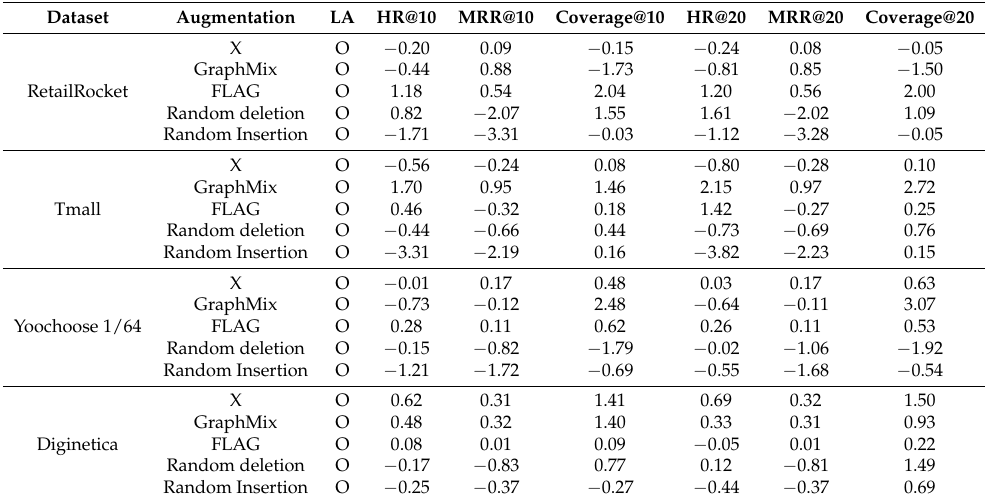
Table 3. The average performance gains (%) of four baseline methods with LA and different data augmentation methods on the original baseline methods.